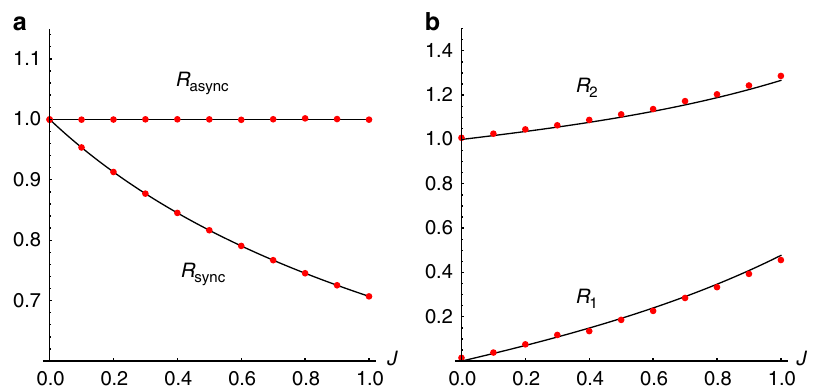
Fig. 4 Radii of stationary states. Simulation were for 800 swarmalators with a linear attraction kernel I att ( x ) = x . Red dots show simulation data, while black curves show theoretical predictions. a Radius of crystal formed in static sync state (for K = 1) and static async state (for K = − 2) vs. J . b Inner and outer radii of annulus in static phase wave state vs.